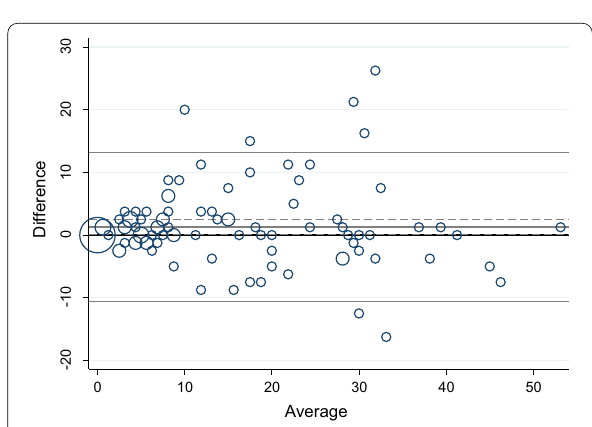
Fig. 2 Differences in the Problem Areas in Diabetes (PAID) scale between first and second questionnaire responses (Test 1 and Test 2) plotted against the mean, N =